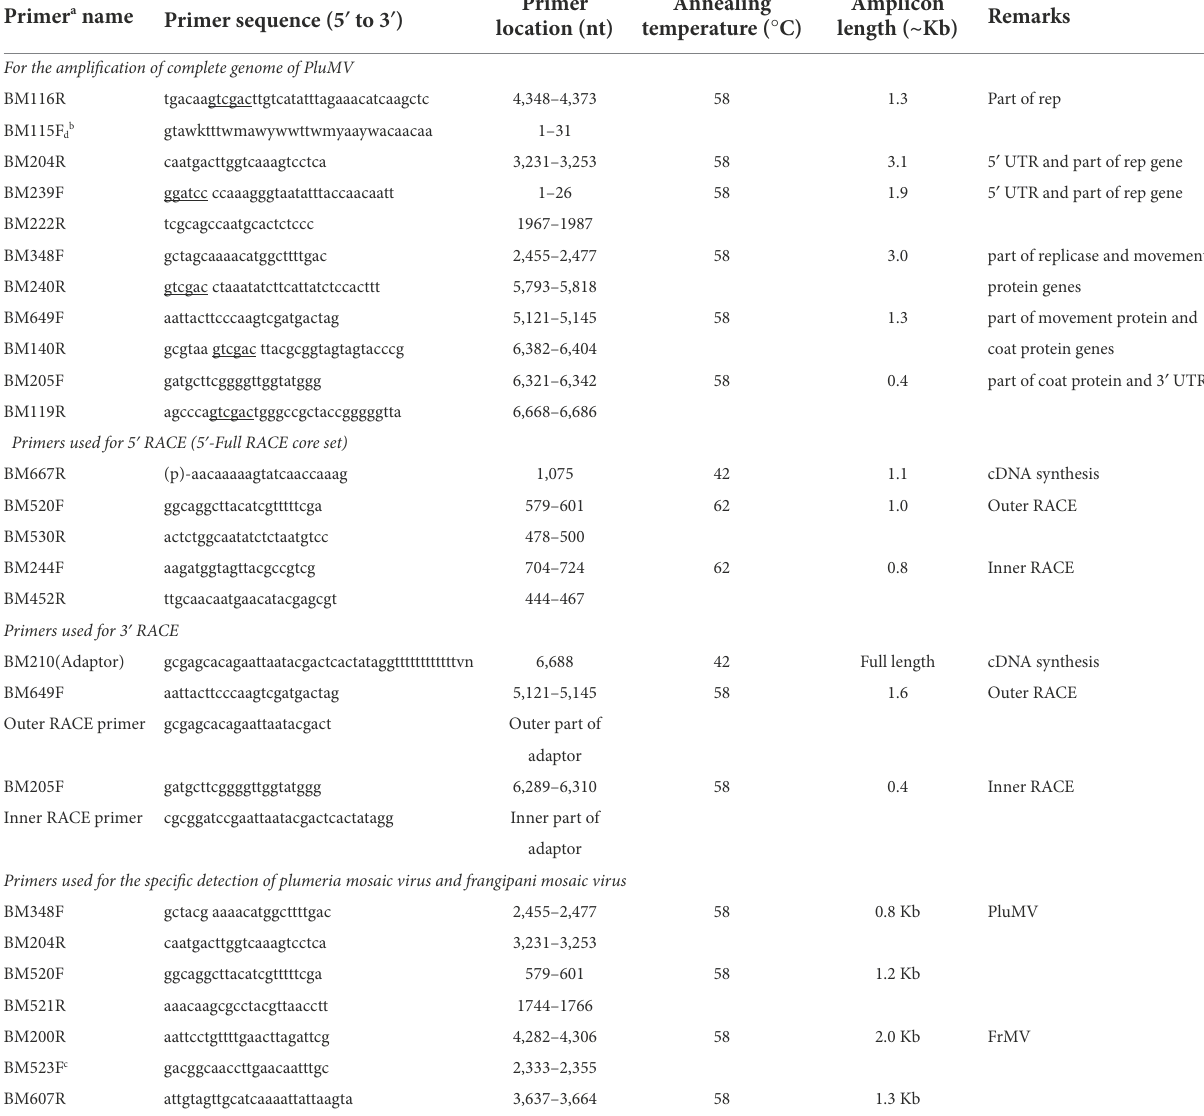
TABLE 2 List of the primers used for the amplification of the complete genome of plumeria mosaic virus (PluMV) from Plumeria rubra F. acutifolia, and for the detection of PluMV and frangipani mosaic virus